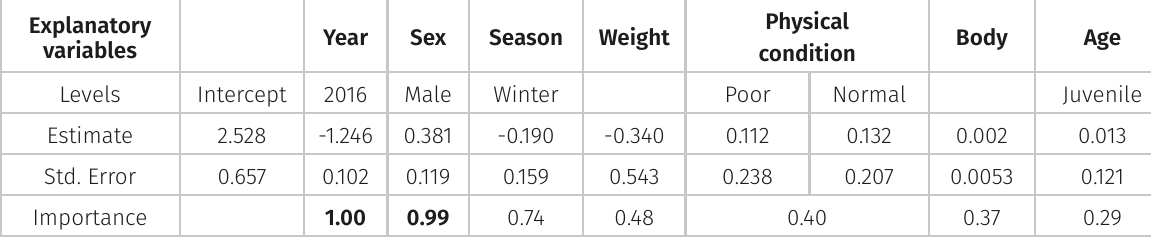
Table III. Averaged General Linear Model coefficients and variable importance. Reference models statistics: AIC null model = 1482.63; Full model: AIC = 1367; θ = 1,117; pseudoR 2 = 44.15%.